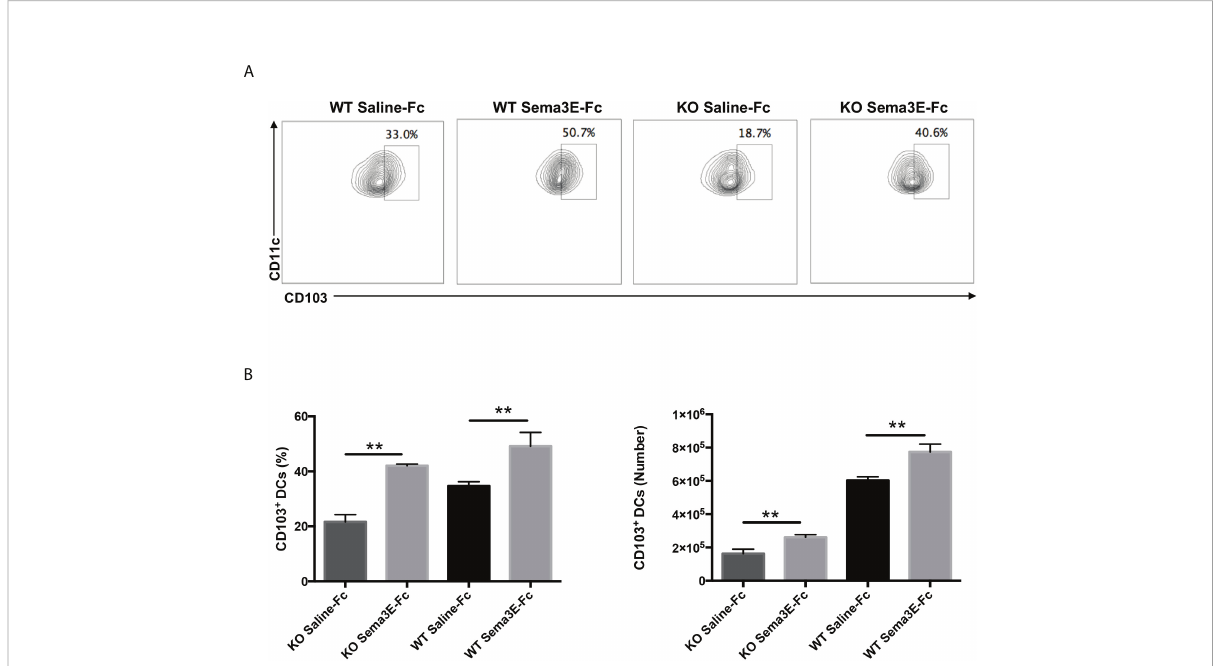
FIGURE 8 Higher CD103 + lung DC subset in Sema3E-Fc treated mice than saline-Fc treated mice after Cm infection. Mice were intranasally inoculated with 1x10 3 IFUs of Cm . Lung cells were collected from Sema3E-Fc, or saline-Fc treated WT and Sema3E KO mice on day 3 post-infection, stained for surface markers and analyzed using fl ow cytometry. (A) Representative fl ow cytometric images of CD103 + lung DC subset. (B) The percentages and number of CD103 + lung DC subset. Data are shown as mean ± SD (n = 3) and represent one of three independent experiments with similar results. ** p <